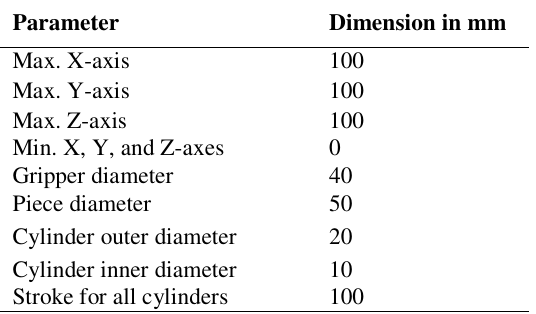
The limitations of mechanical dimensions setup. Parameter